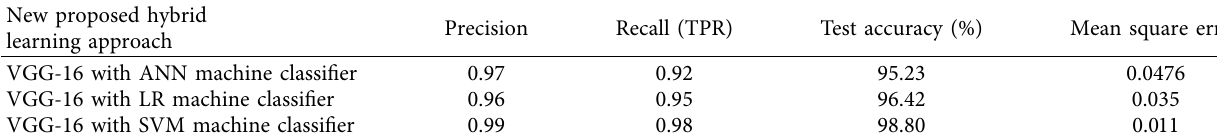
Table 10: Comparison of the best new proposed hybrid learning approach.